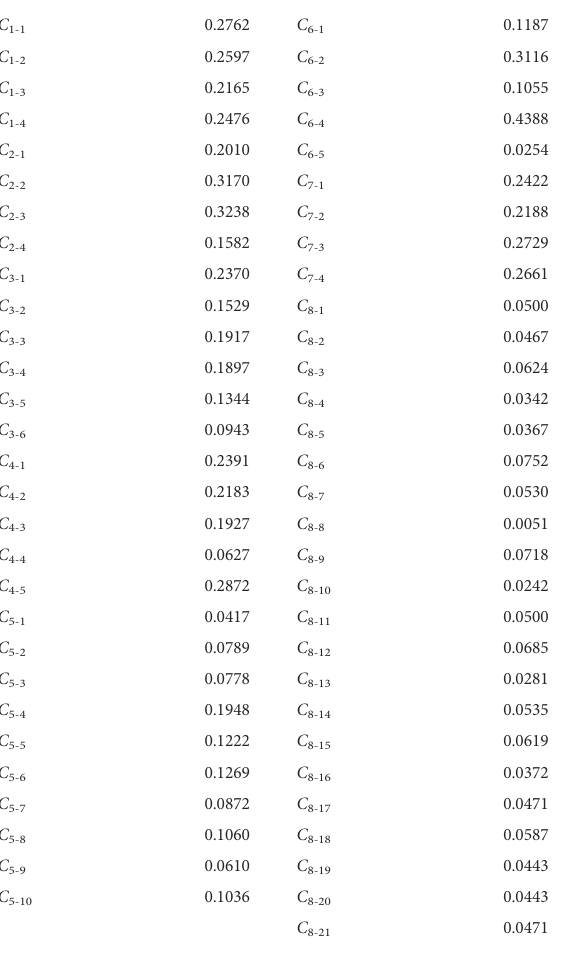
TABLE 4 Weights of one-level and two-level